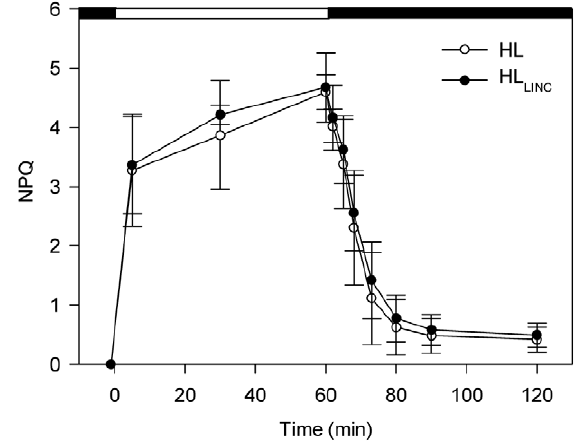
Figure 6. Variation of non-photochemical quenching (NPQ) in Phaeodactylum tricornutum . Measurements before and during exposure to 1 h of high irradiance (1,250 m mol photons m 2 2 s 2 1 ), and subsequent recovery in the dark. Treatments: HL (control samples); and HL LINC (LINC inhibited samples). Mean 6 standard deviation (n=5).